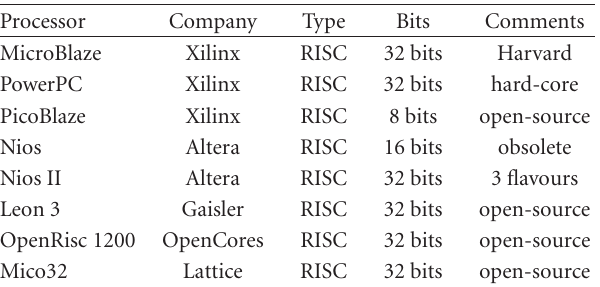
Table 1: Main FPGA processor